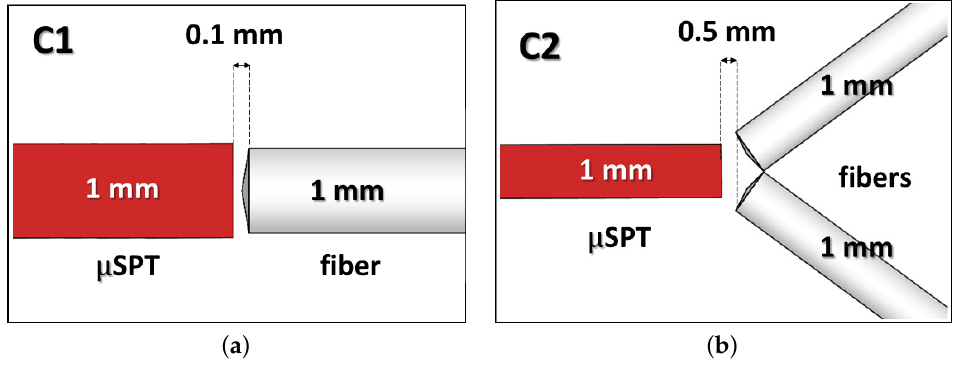
Figure 7. Two different configurations of light acquisition between the output fibers and the µ SPT . ( a ) Configuration 1 (C1) shows one optical fiber placed horizontally with respect to the µ SPT . ( b ) Configuration 2 (C2) shows two optical fibers tilted, in opposite directions, at 36 ◦ , with respect to the µ SPT